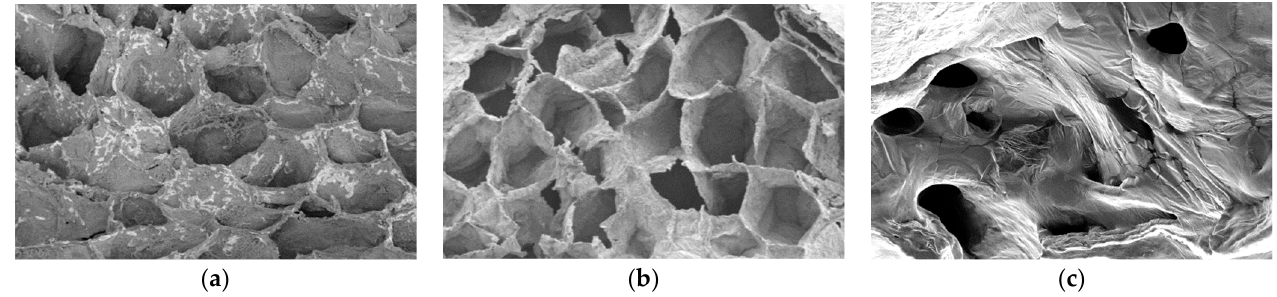
Figure 1. SEM images (at 300 magnification) of the final dried samples in the three drying methods. ( a ): IFD for 12 h; ( b ): CFD for 12 h; ( c ): AD for 6